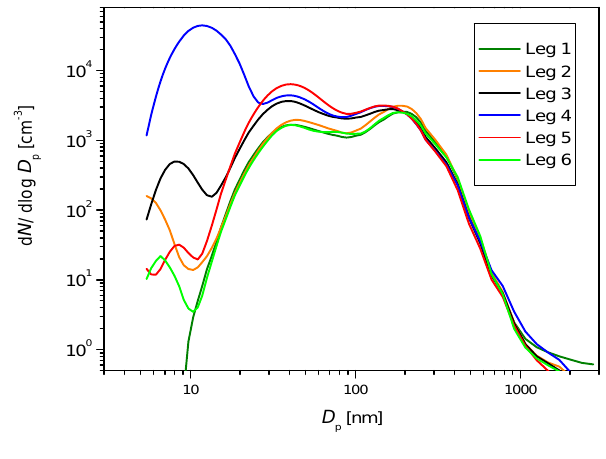
Fig. 5. Mean number size distributions measured during horizontal flight legs 1 to